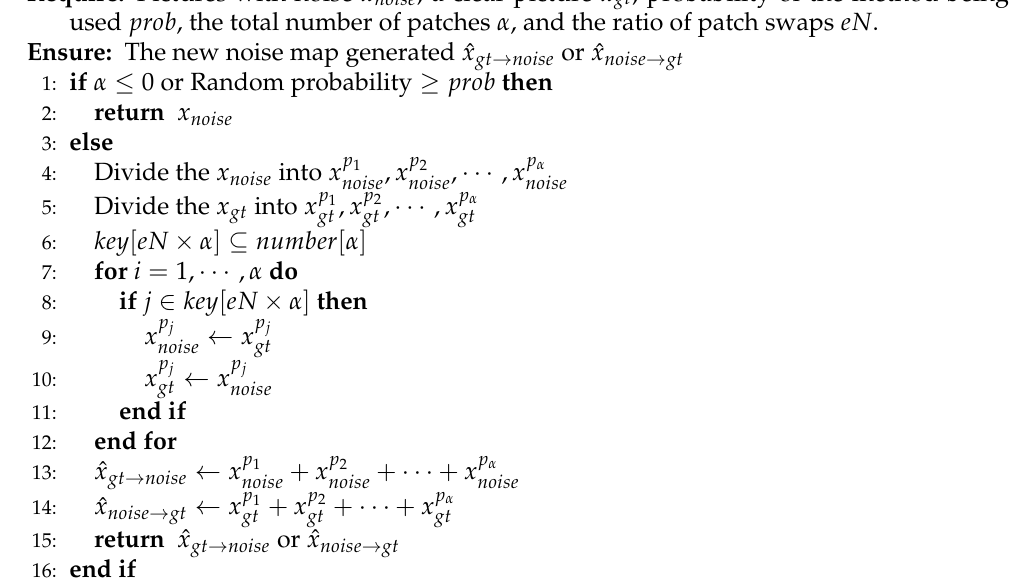
Algorithm 1 PatchMask implementation